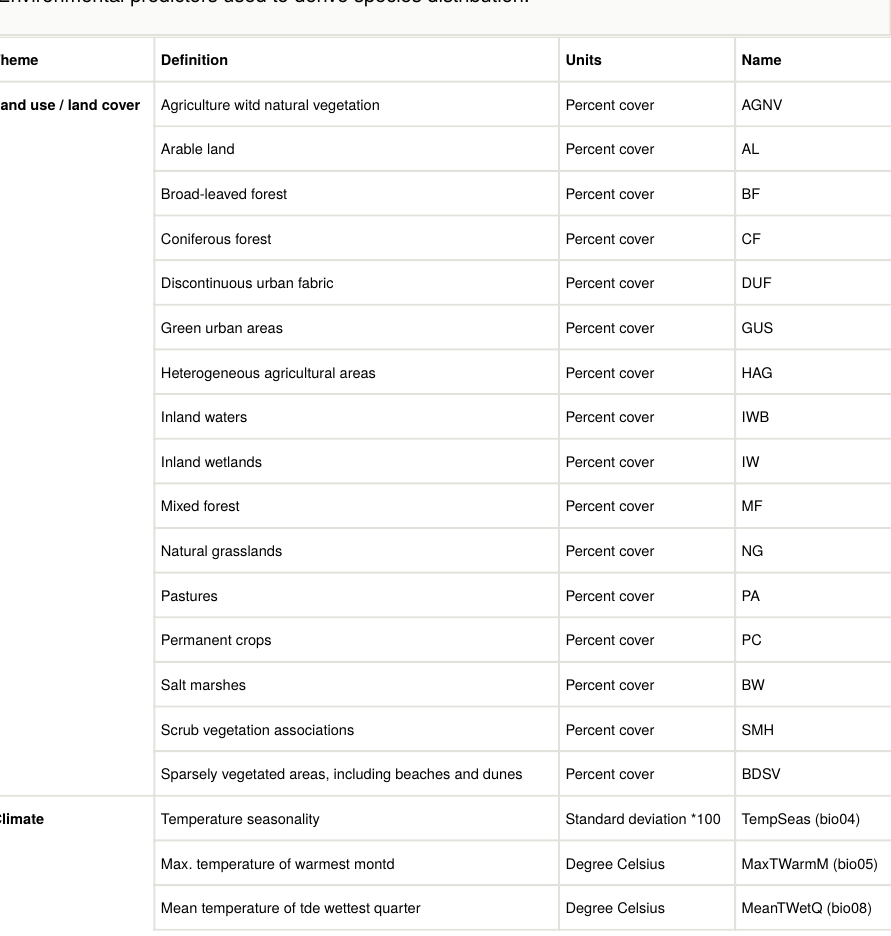
Environmental predictors used to derive species